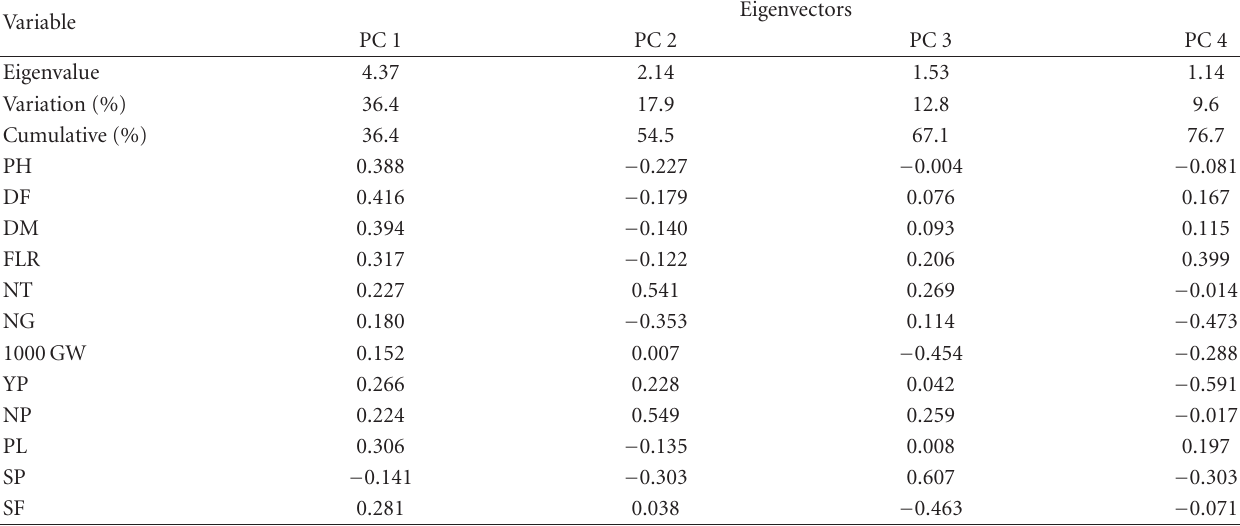
Table 9: Eigenvectors and eigenvalues of the first four principal components.